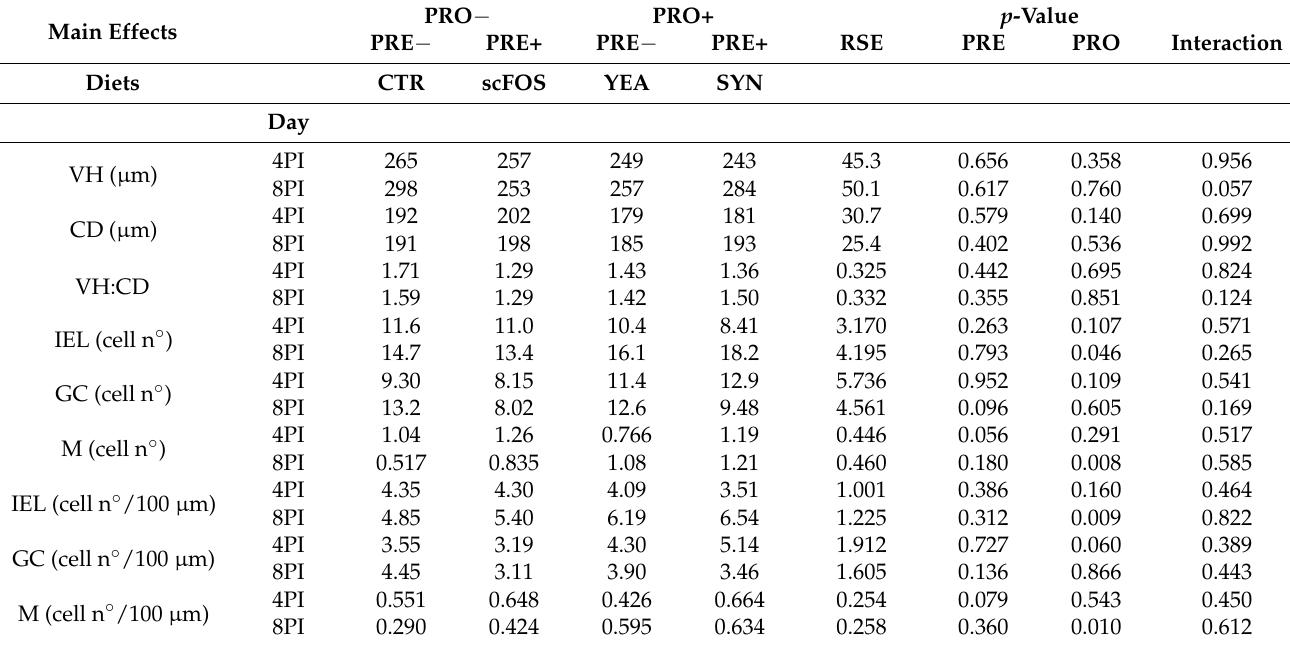
Table 8. Treatment effects on ileal histomorphology measured at 4 and 8 days post